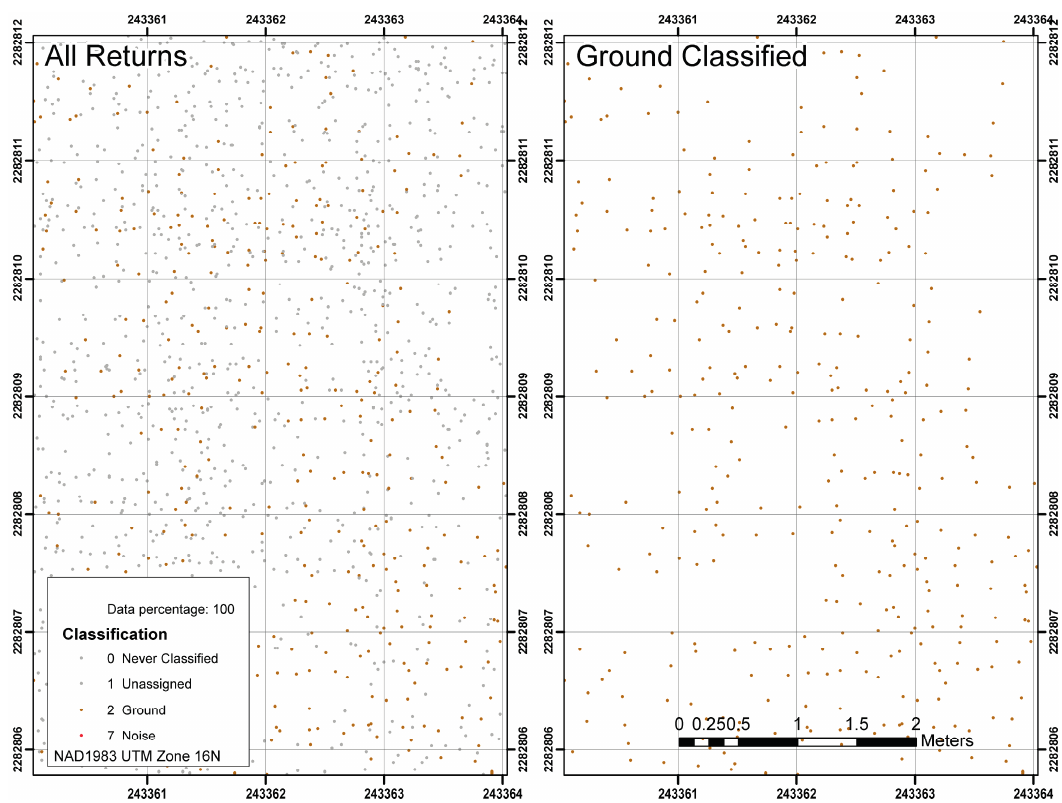
Figure 6. Maps comparing LiDAR point densities on a one meter grid (points colored by type of return).